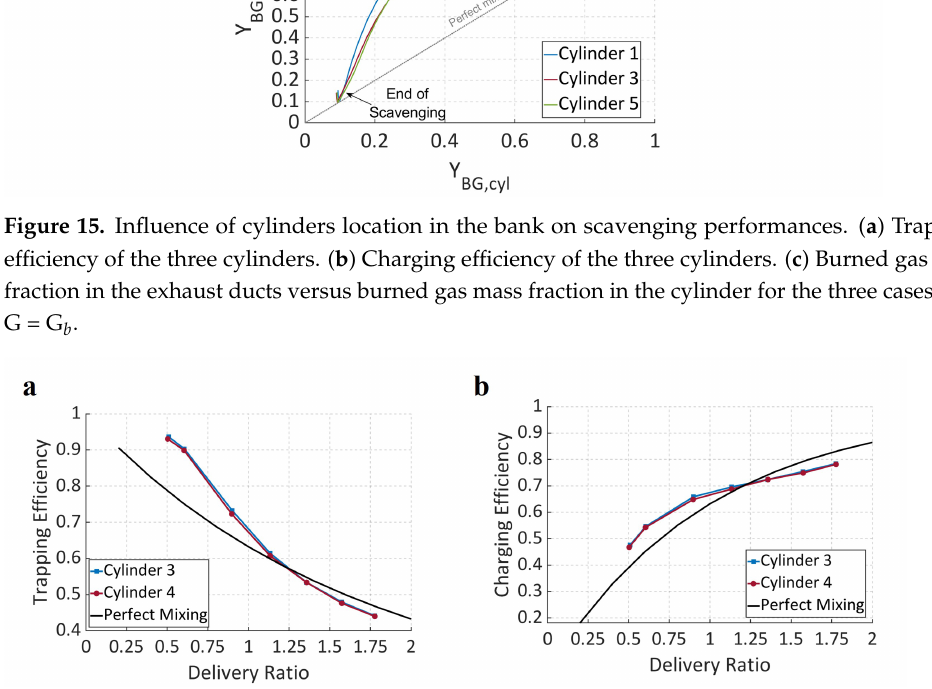
Figure 16. Scavenging performances of right and left banks of GF56. Trapping ( a ) and charging ( b ) efficiencies of Cylinder 3 and Cylinder 4 as a function of delivery ratio for G = G b